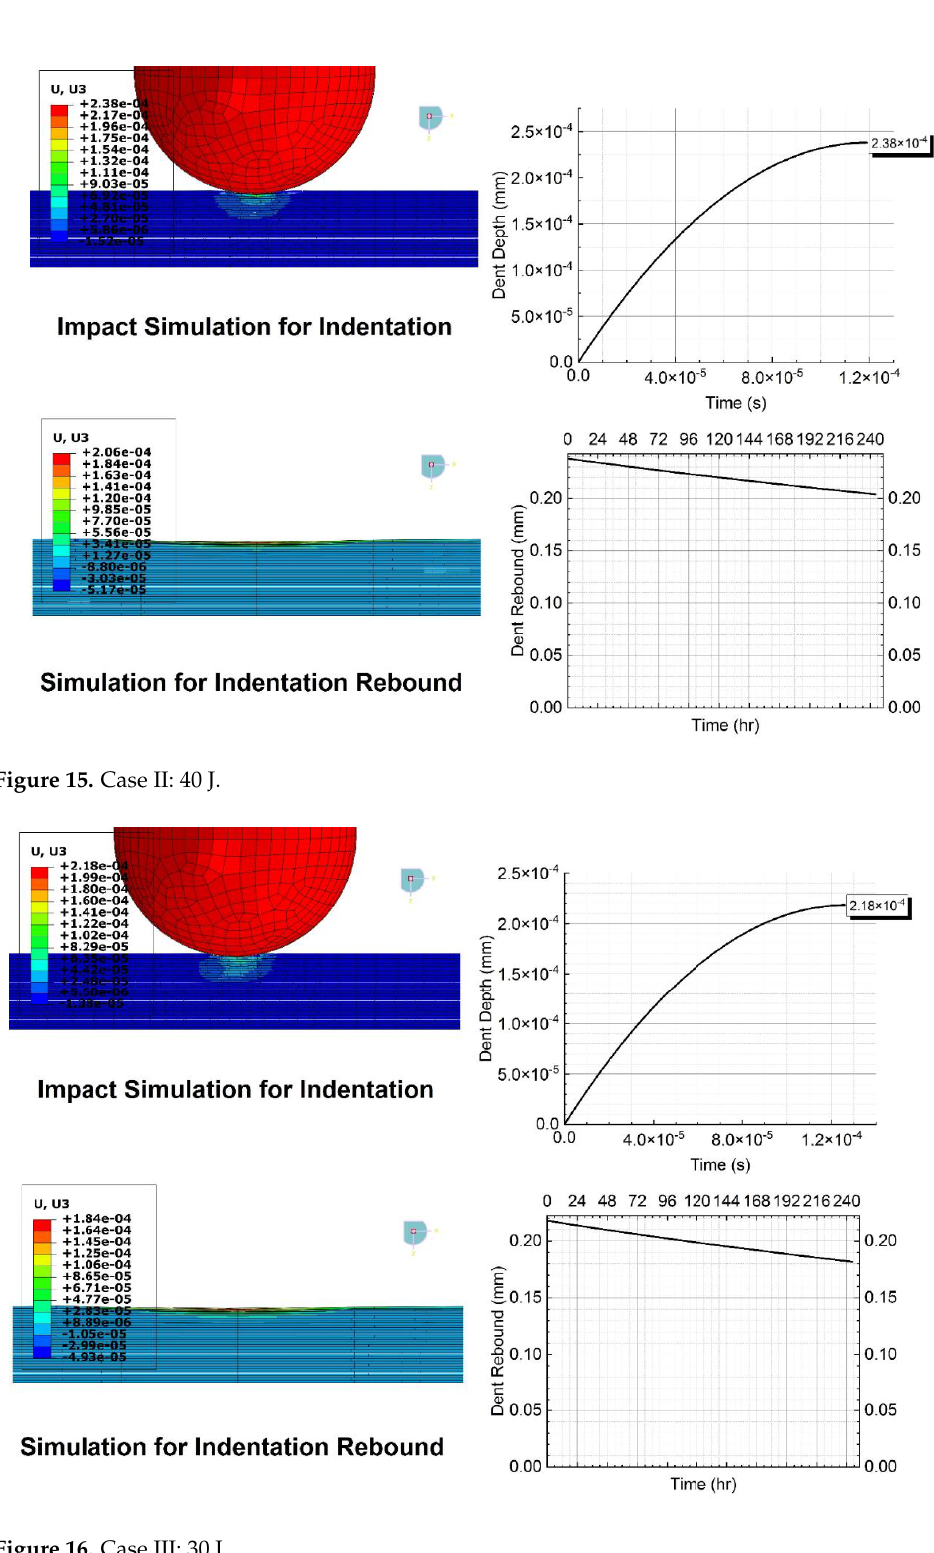
Figure 16. Case III: 30